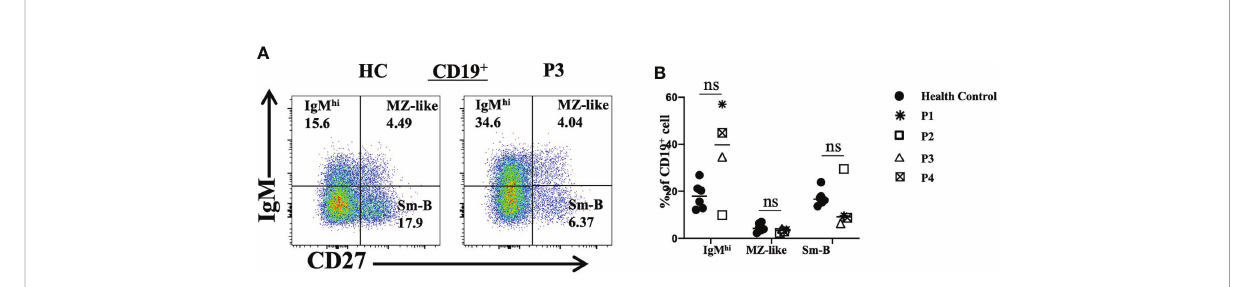
FIGURE 5 Flow cytometric analysis of peripheral B-cell subsets in patients with FOXP3 de fi ciency. (A) and (B) The percentages of IgM hi B cells (CD19 + IgM + CD27 - ), MZ-like B cells (CD19 + IgM + CD27 + ) and smB cells (CD19 + IgM - CD27 + ) among B cells *P<0.05; ns, no signi fi